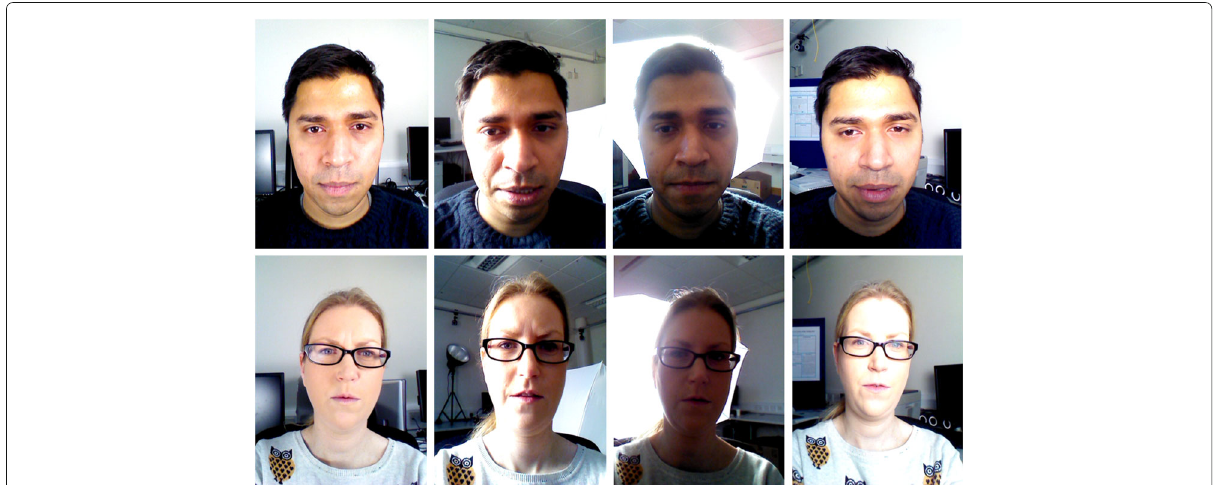
Fig. 5 A sample of 2 participants from FAVLIPS showing the range of lighting conditions captured. Lighting condition from left to right: neutral, side, behind, and front